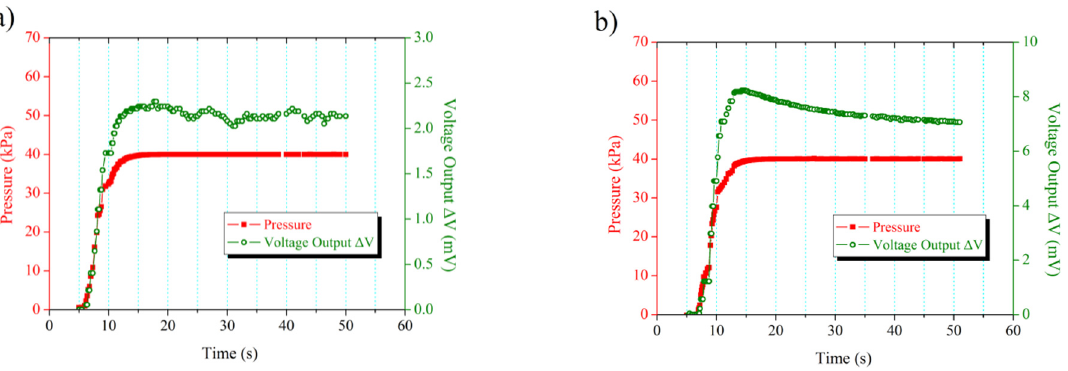
Figure 7. Dynamic response of voltage output with differential pressure: ( a ) without annealing; ( b ) with 300 °C annealing in atmosphere.